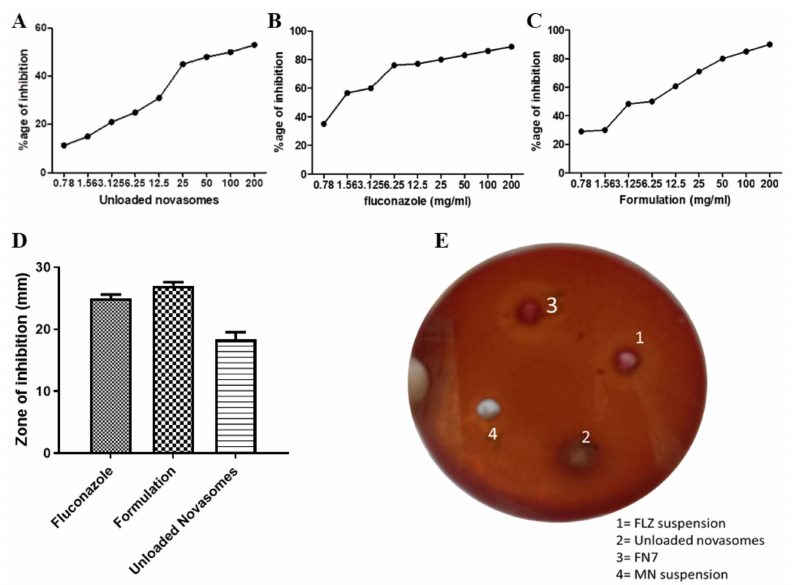
Figure 6. Percentage (%) of inhibition ( A – C ) and zone of inhibition ( D ). Values are expressed as mean ± SEM (n = 5), ns = non-significant compared to FLZ suspension. Antifungal activity of FN7, unloaded novasomes, FLZ suspension and standard drug ( E